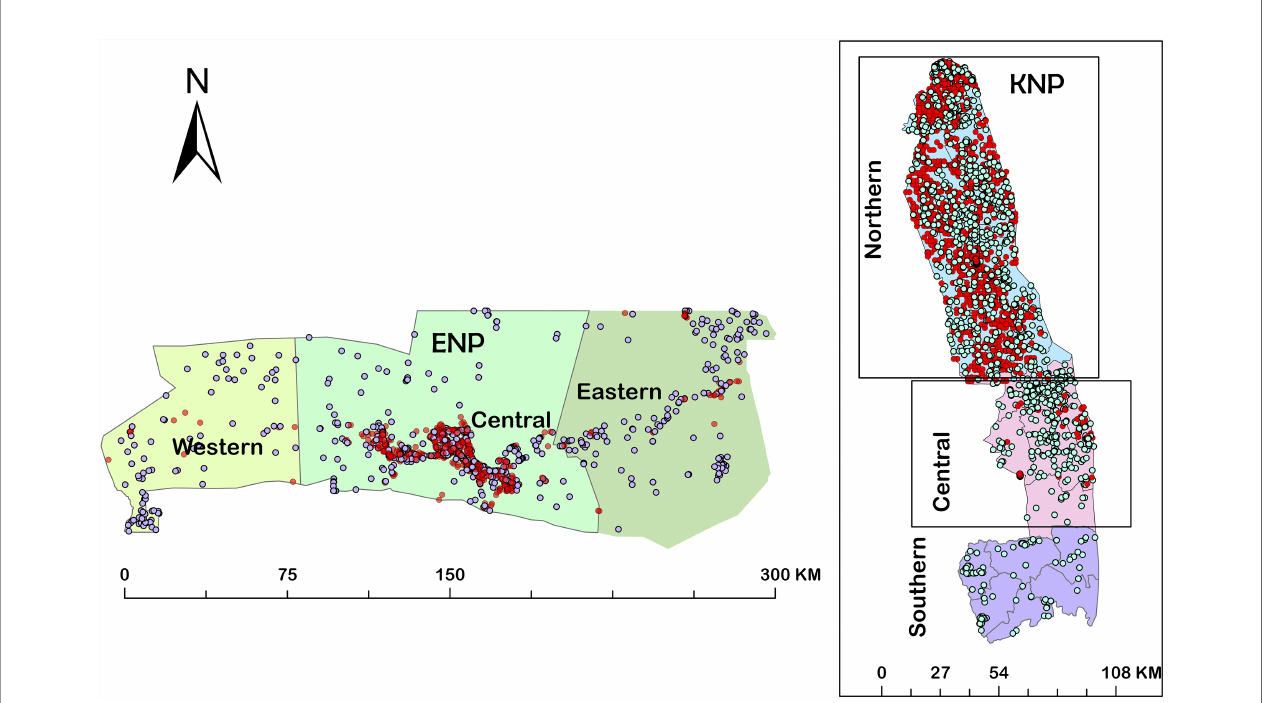
FIGURE 3 | Maps showing distributions of mortalities from 1990-2015 in the three regions of Kruger National Park (KNP), South Africa and from 1996-2016 in the three regions of Etosha National Park (ENP), Namibia. Red dots indicate anthrax positive mortalities and the white dots indicate non-anthrax